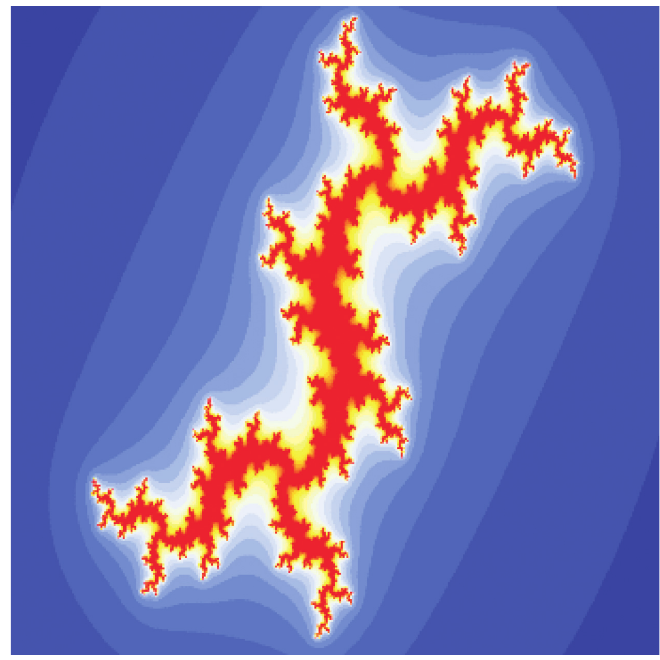
Figure 6: Quadratic Julia set in JSOmhh.